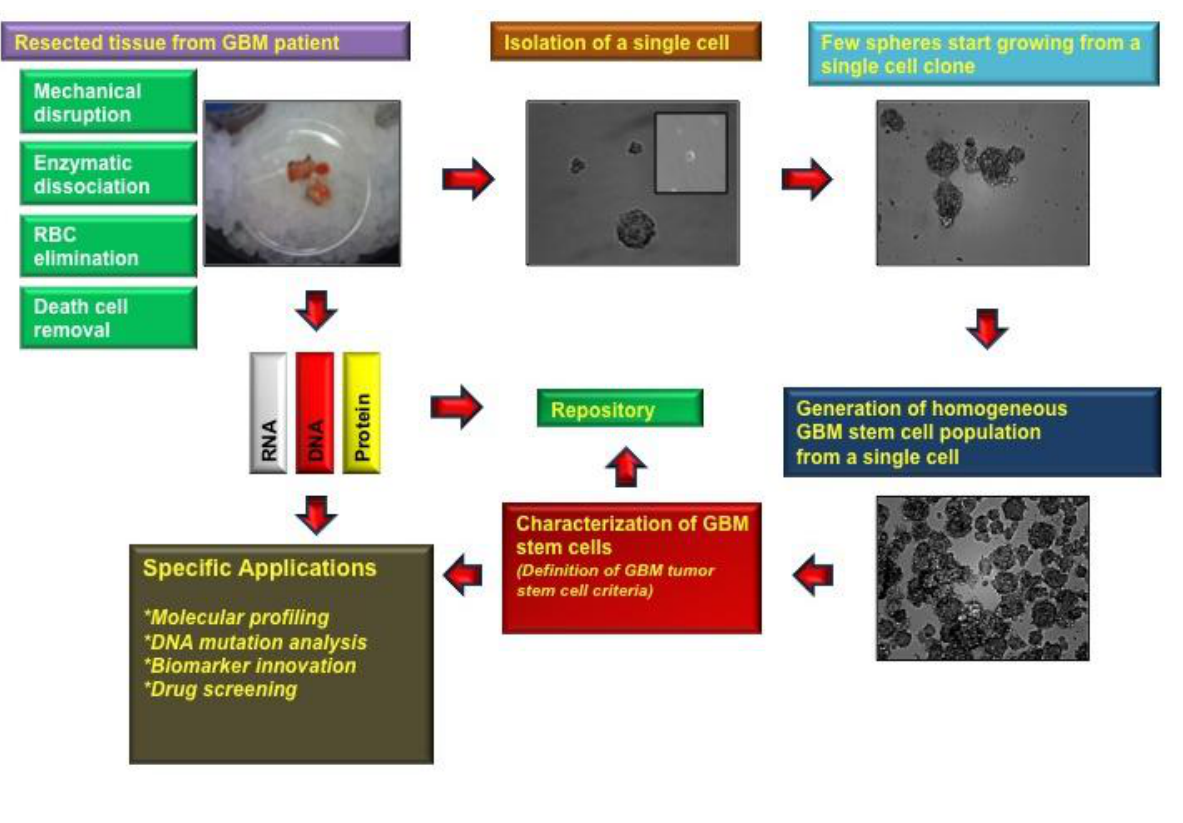
Figure 1. Organizational chart for glioblastoma multiforme (GBM) stem cell and tissue isolation from patient